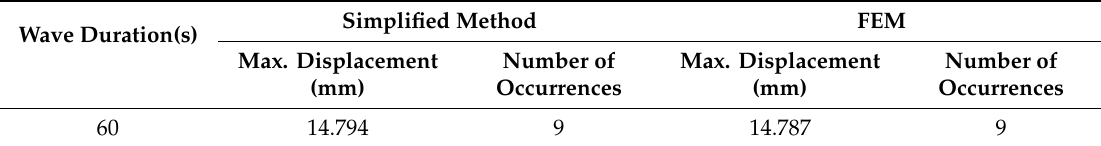
Table 4. Extremums for the jacket-top